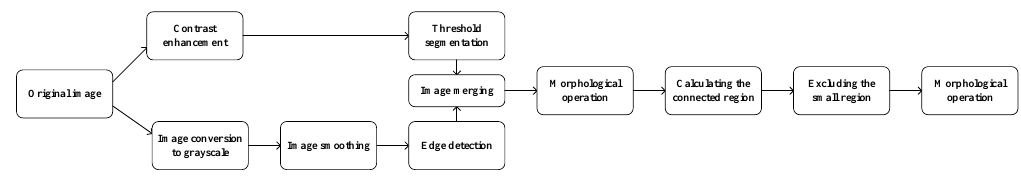
Figure 2. Flow diagram of the proposed sea-land separation algorithm.